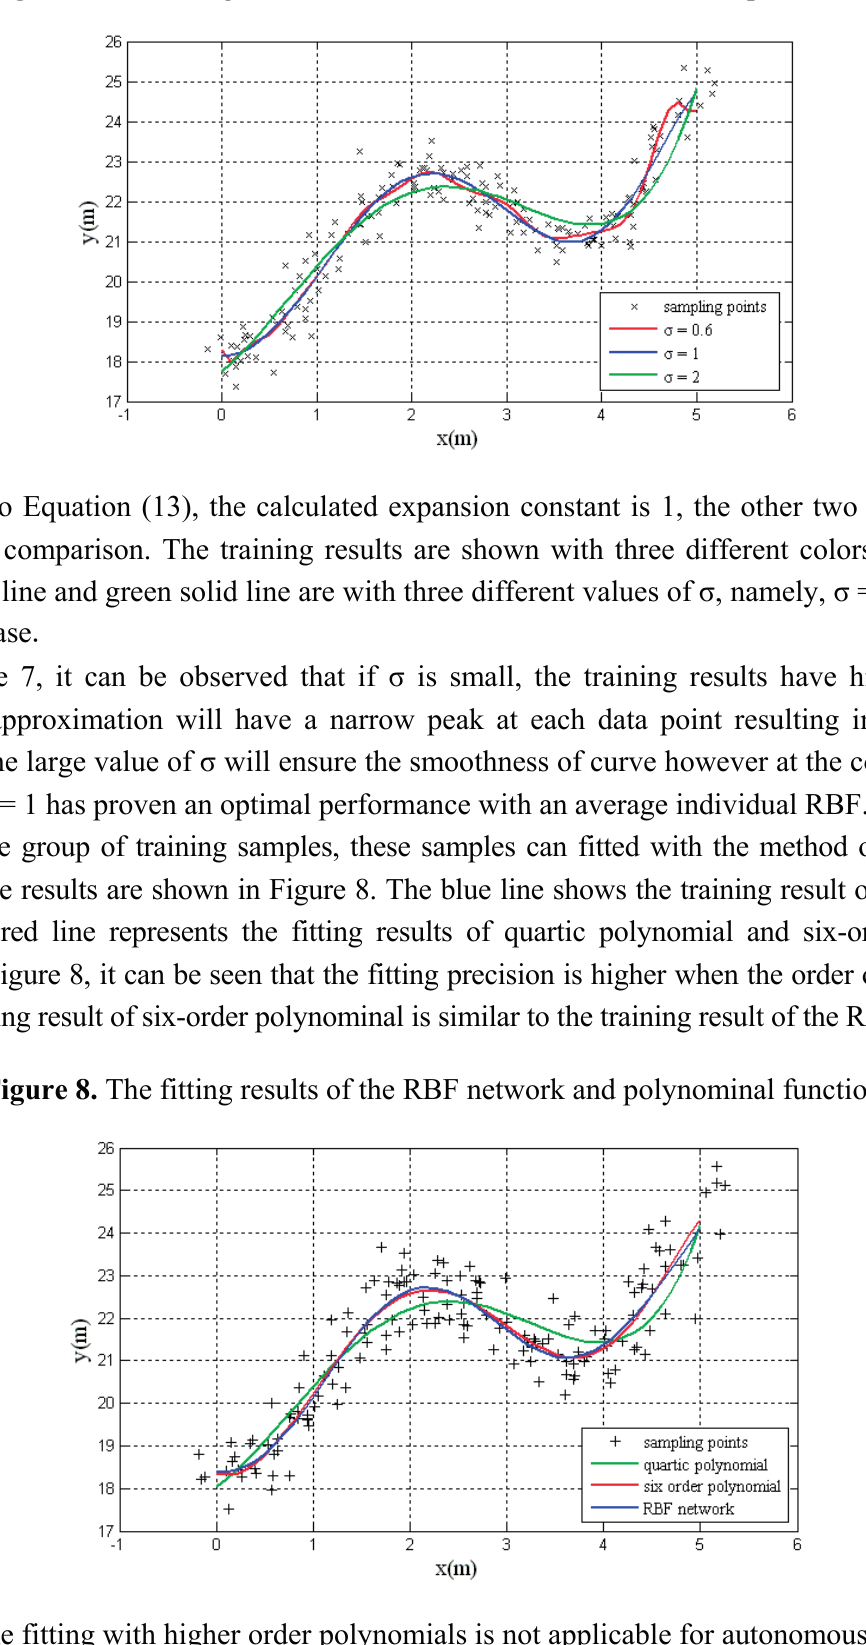
Figure 7. The fitting results of the RBF network with different parameters.